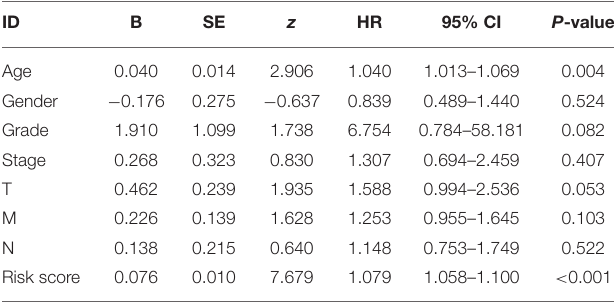
FIGURE 3 | Kaplan–Meier (KM) survival curve of the autophagy-related lncRNA BC risk score in TCGA training group. In the TCGA data, the 5-year survival rate of high-risk patients is lower than that of low-risk patients. TABLE 3 | Multivariate Cox regression analysis of characteristics and risk score in BC.